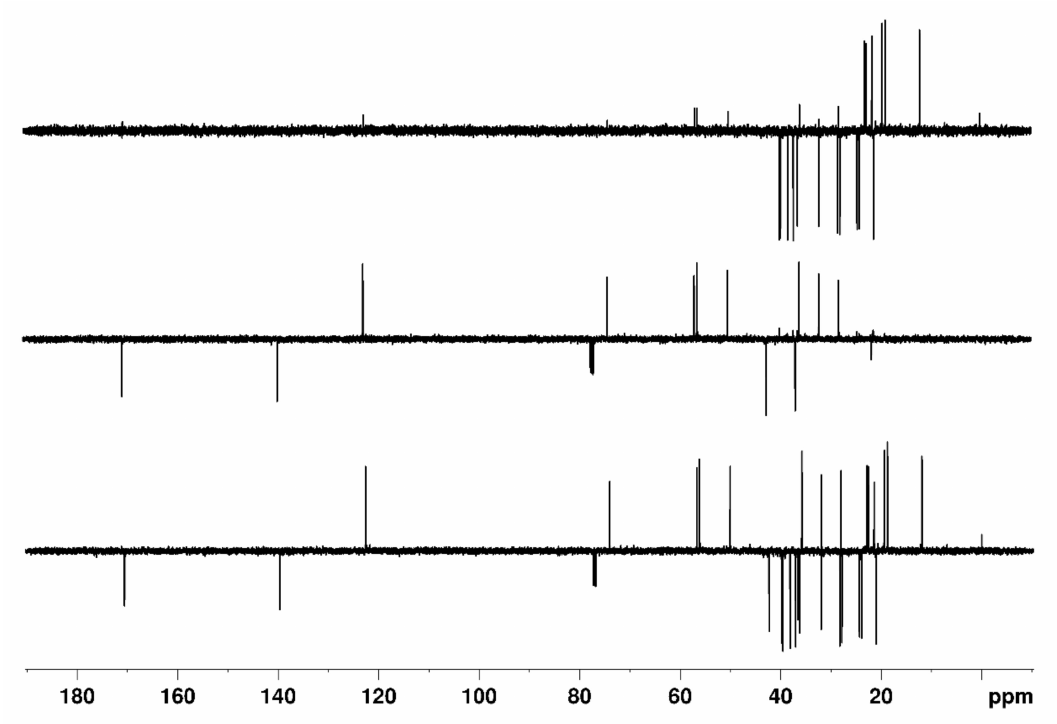
Figure 4. Bottom : DEPTQ135 90 ; middle : DEPTQ90 45 ; top : Difference between DEPTQ135 90 and DEPTQ90 45 spectra of 30 mg of cholesteryl acetate dissolved in 0.7 mL CDCl 3 . The delay δ was set to 3.45 ms, adjusted for a coupling constant 1 J CH of 145